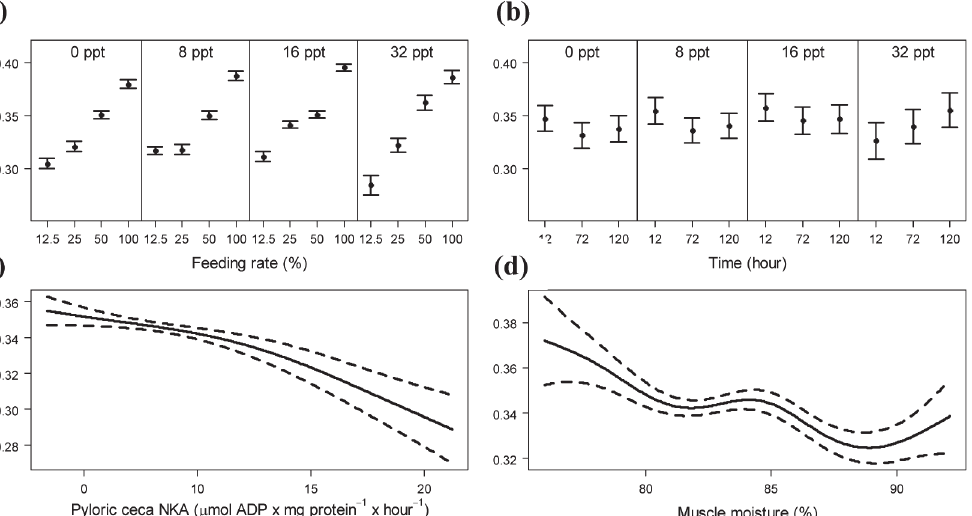
Fig 3. Generalized additive model fits and 95% confidence intervals from the optimal model for green sturgeon. Relationships between growth performance of juvenile green sturgeon, measured by condition factor, and each explanatory variable (FR × salinity interaction, time × salinity interaction, pyloric ceca NKA, and muscle moisture). Sturgeons were challenged in a multiple-factor setting, first to levels of feeding rate (12.5, 25, 50, 100%), and then to salinity levels (0, 8, 16, 32 ppt) for a given time (12, 72, 120 h). W = weight; L =